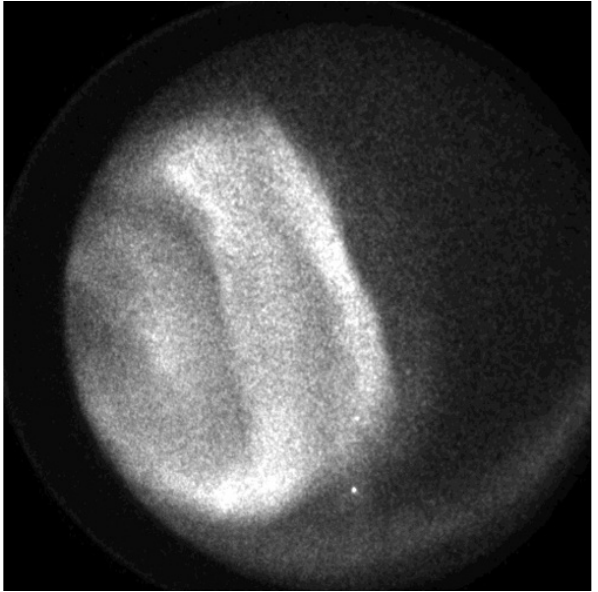
Fig. 4. UiO (University in Oslo) all-sky camera, red line 630 nm filter, for 9 January 2008, 20:17UT. Northward direction is on the top of the image. Eastward on the